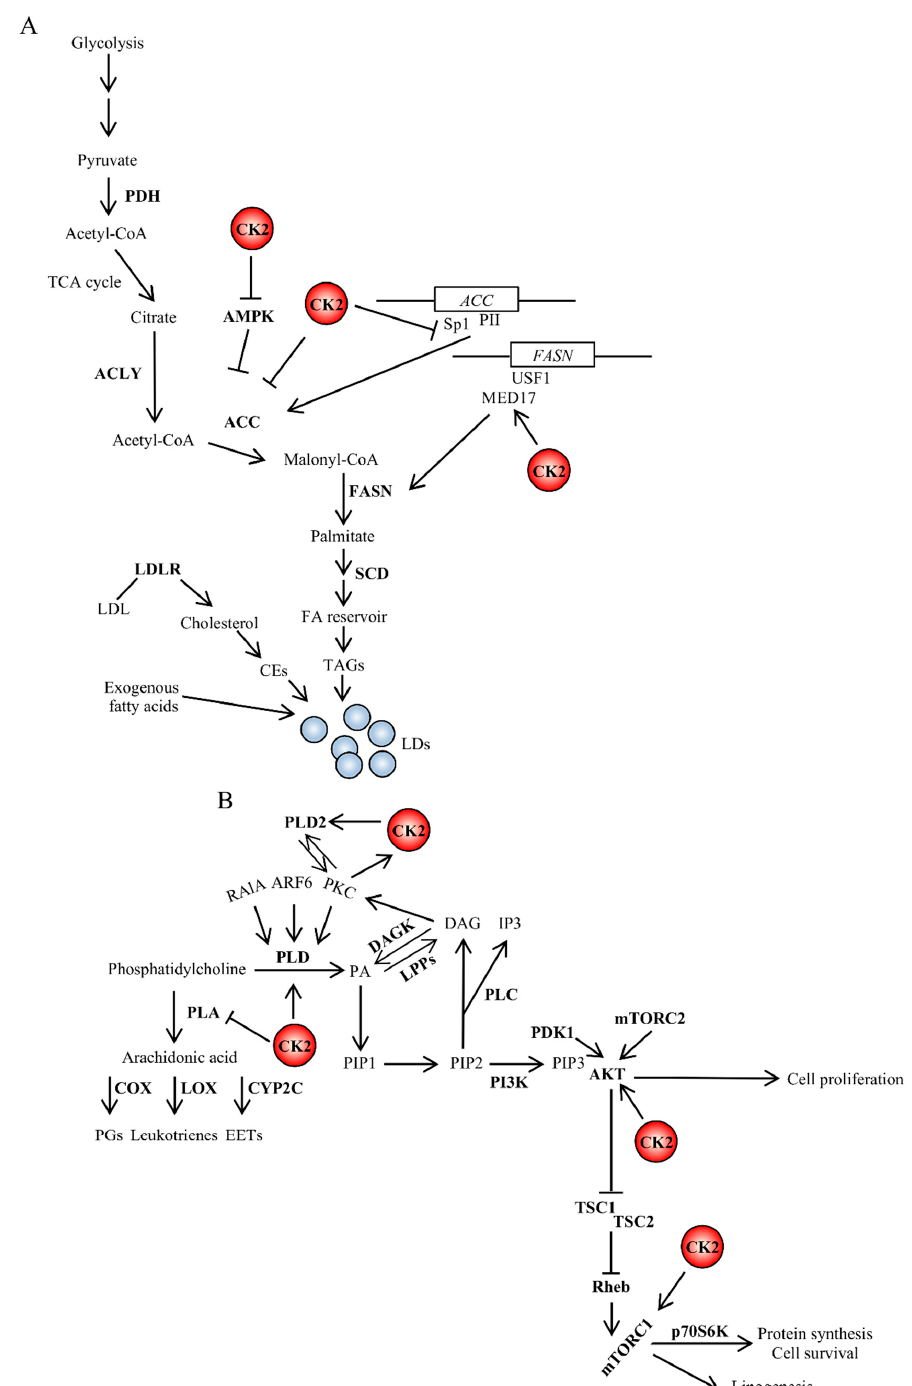
Figure 2. Crosstalk between CK2 and signaling pathways ( A ) regulating fatty acid synthesis or ( B ) controlled by phospholipases. CK2 is an important regulator of lipid homeostasis by stimulating fatty acid and protein synthesis and promoting cell survival. The interrelatedness between CK2 and lipid signaling occurs at multiple levels. The PI3K / AKT signaling pathway promotes lipid synthesis. Active AKT stimulates mTORC1, which, in turn, regulates several intracellular processes including cap-dependent translation, lysosomal biogenesis and lipid homeostasis. CK2 can directly phosphorylate AKT contributing to increase its catalytic activity [173]. Further details are discussed in the text. DAGK, diacylglycerol kinase; LPPs, lipid phosphate phosphatases; PA, phosphatidic acid; p70S6K, ribosomal protein S6 kinase beta-1; Rheb, Ras homolog enriched in brain; TSC1, tuberous sclerosis 1; TSC2, tuberous sclerosis